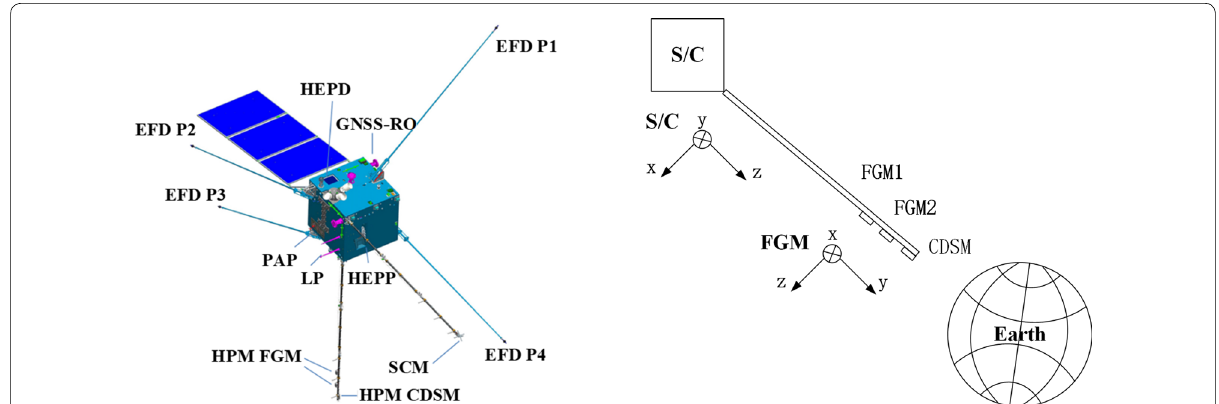
Fig. 2 Drawing of satellite with the HPM sensors on the boom and sensor coordinate system. All three sensors are mounted on the outermost segment of the boom, when the CDSM sensor is mounted on the tip and two FGM sensors are located between the CDSM and spacecraft body